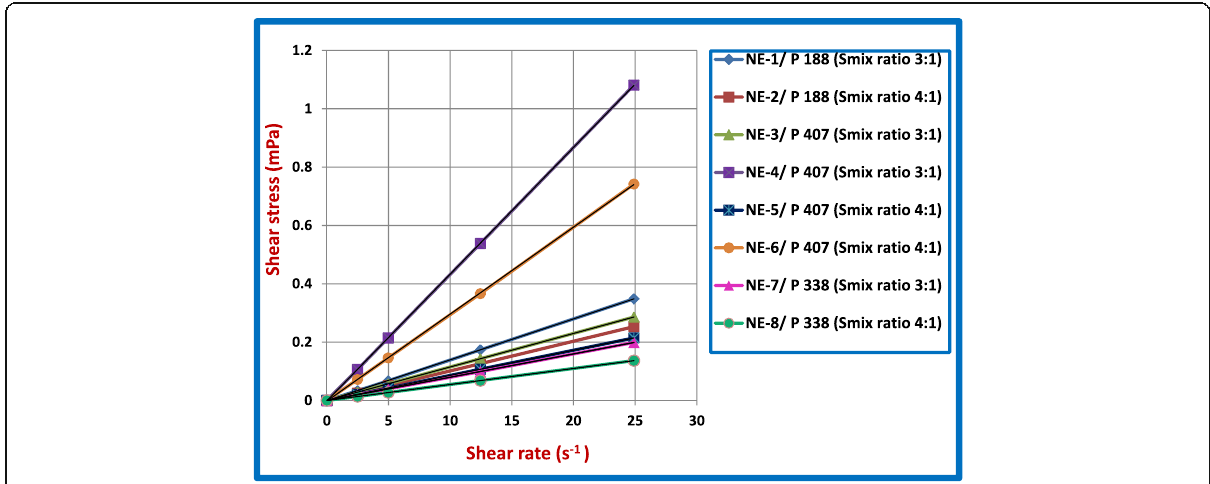
Fig. 6 Rheogram of candesartan cilexetil nanoemulsions (NE-1, NE-2, NE-3, NE-4, NE-5, NE-6, NE-7 and NE-8)